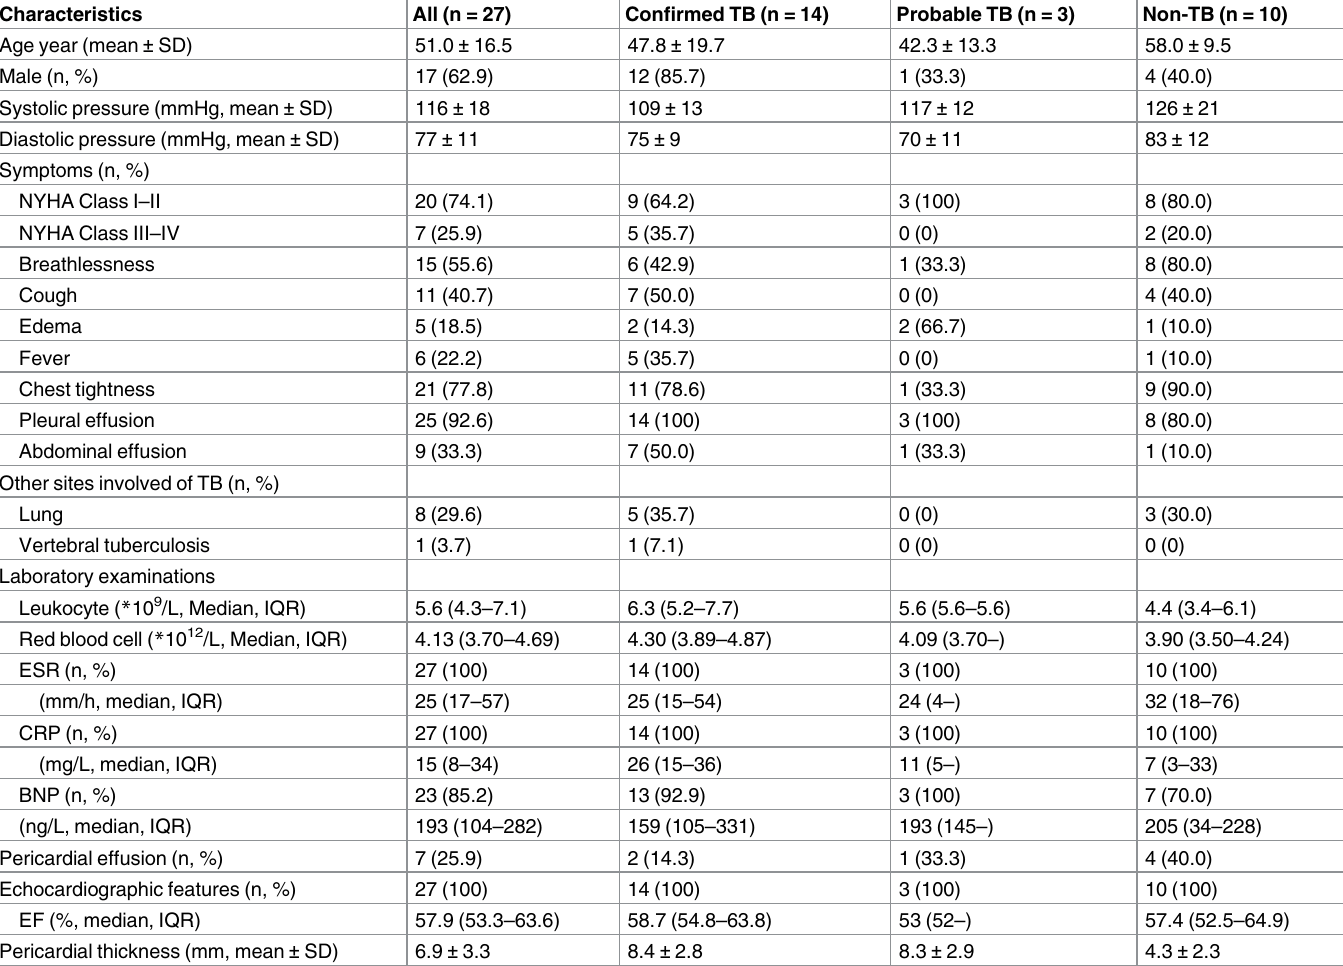
Table 1. Clinical featuresof patients suspected of tuberculous pericarditis.